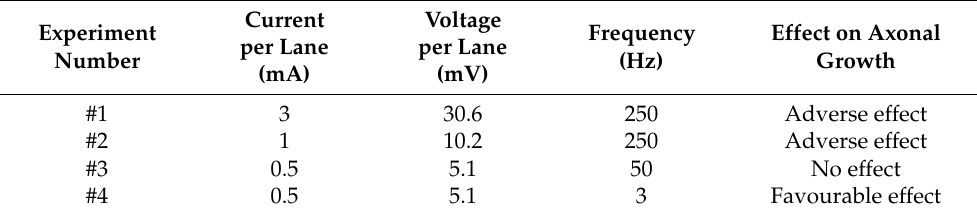
Table 1. Stimulation parameters: different electric currents and frequencies were applied to the cultures, evaluating their effect on axonal growth. The total stimulation time (3 days), the continuous stimulation time per day (8 h), the culture duration (4 days), the pre-seeding of SCs (40,000 cells/well), the origin of DRG (chicken embryos) and the age of DRG (E8) were kept